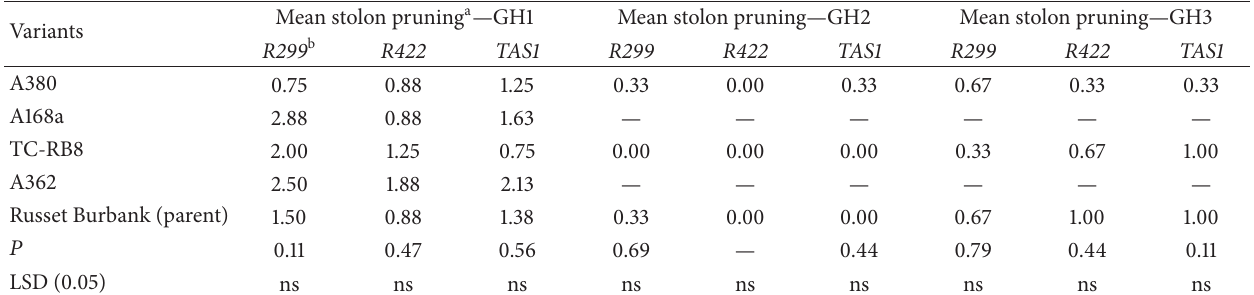
Table 4: Susceptibility to Rhizoctonia stolon pruning of selected potato cv. Russet Burbank variants in glasshouse (GH1—2010; GH2 and